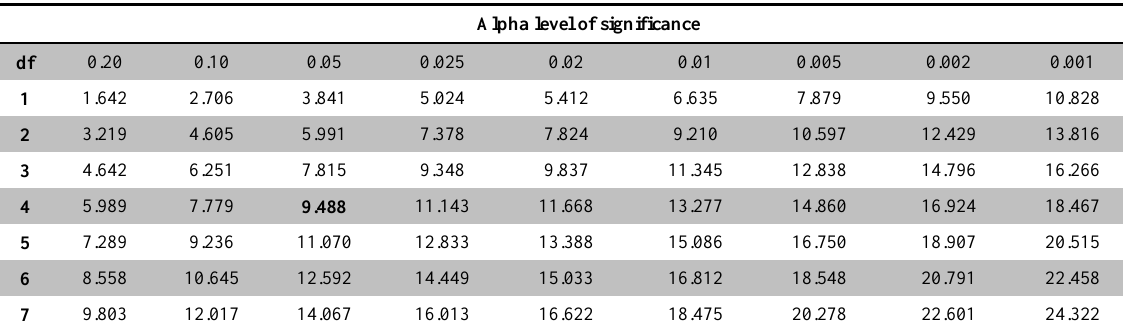
Table 4. Theoretical 𝝌